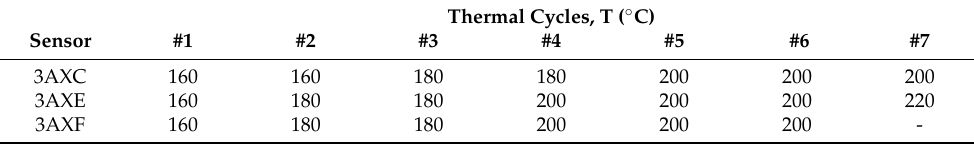
Table 7. Number and conditions of applied thermal cycles for each sensor